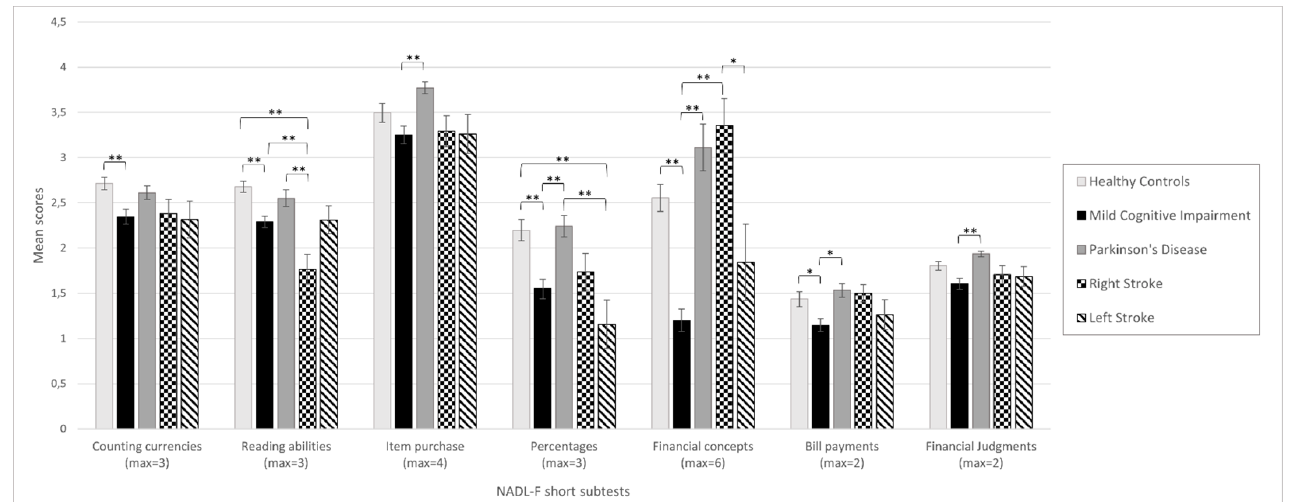
Figure 1. Mean scores at each NADL-F short subtest across all of the groups. The maximum score that can be obtained for each subtest is reported in parentheses. Error bars show standard errors of the means. Asterisks represent significant differences (* p < 0.01; ** p < 0.001). Table 2. Significant multiple regression models for FDM in each group. Bold indicates statistically significant values.